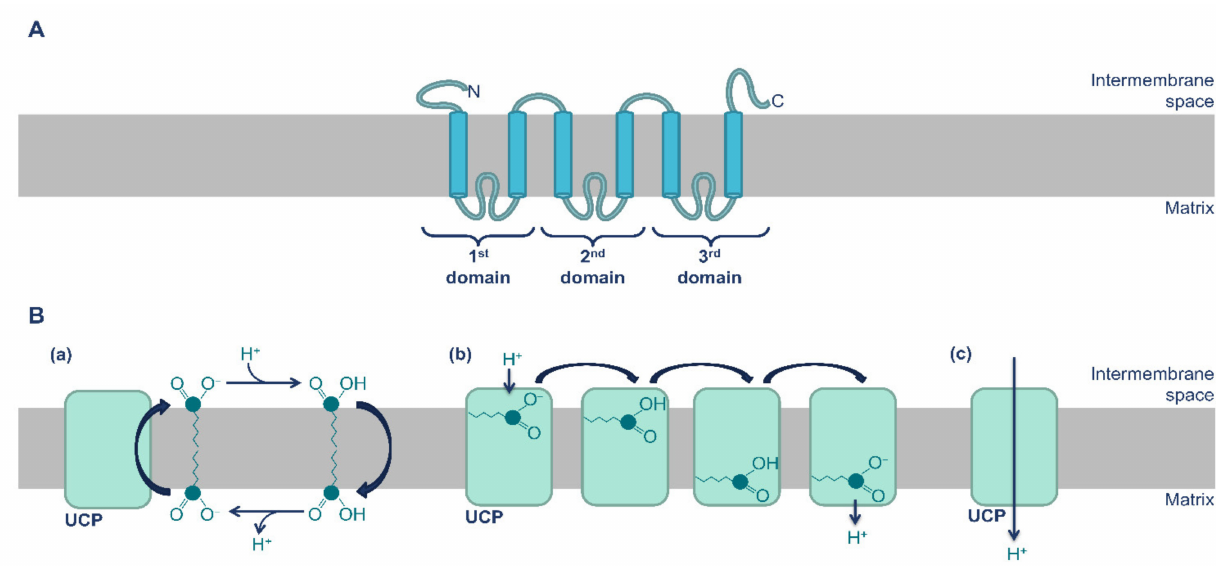
Figure 2. Molecular structure and hypothesized models for proton transport by UCPs. ( A ) UCPs are constituted by three repetition domains, each composed of two α -helix regions. ( B ) The proposed models for proton transport by UCPs are ( a ) flip-flop model; ( b ) cofactor model (transport linked to fatty acids); ( c ) cofactor model (independent transport).